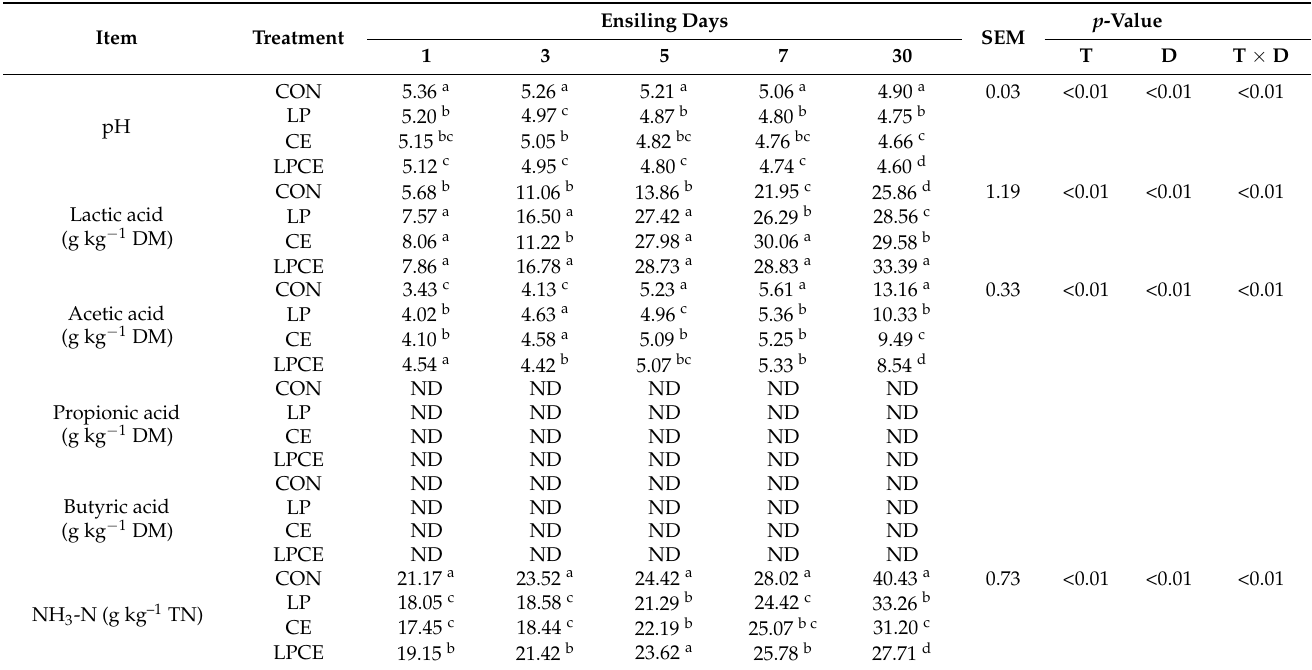
Table 2. Effects of additives on mixed silage fermentative characteristics, WSC and DM contents of